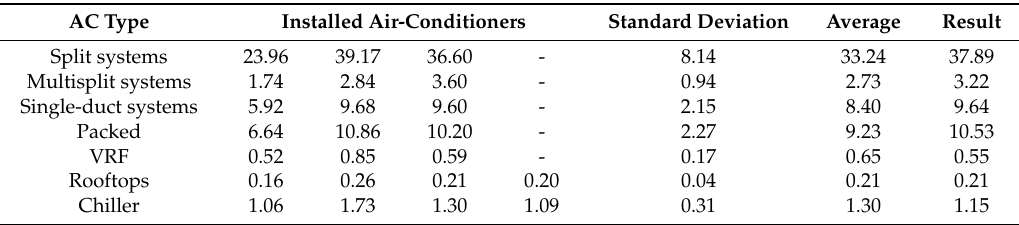
Table A3. Statistical calculations regarding the amount of air-conditioners installed per type, EU15, (Mil. units) [15,16,20–25,36,71–75].